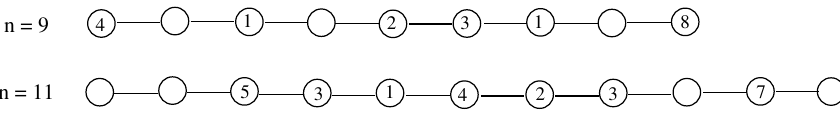
Figure 9: Antiregular dominating labelings of P